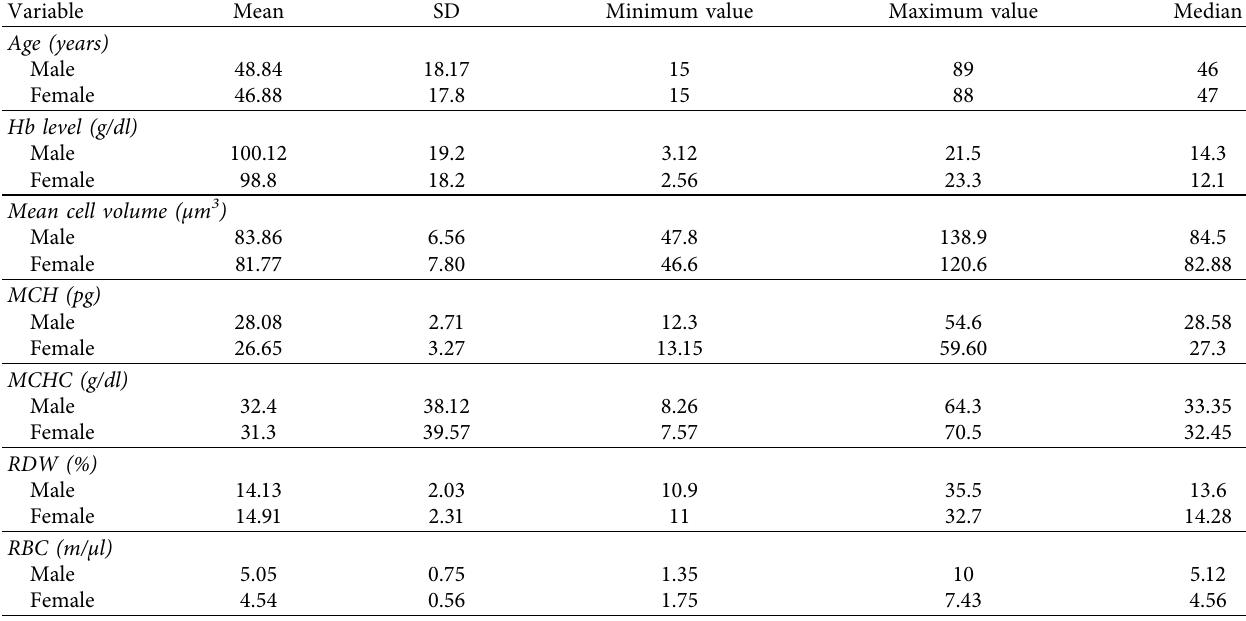
Table 2: Hematological variables and demographic data.